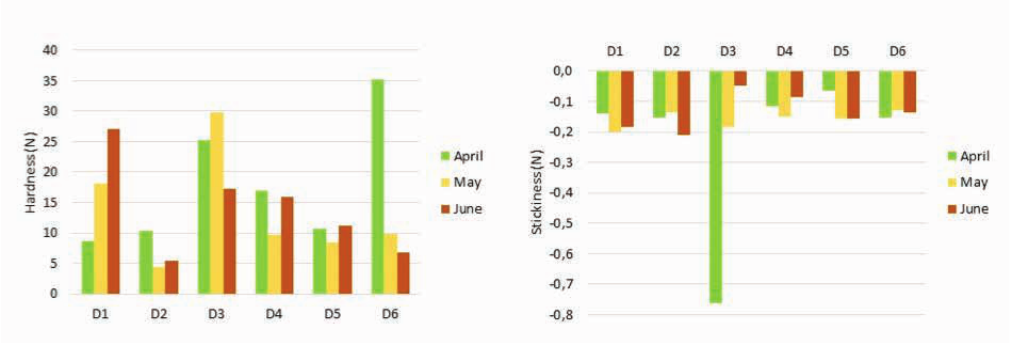
Figure 6: Variation of textural properties in the cheeses as a whole from April to June, obtained by the spreadability